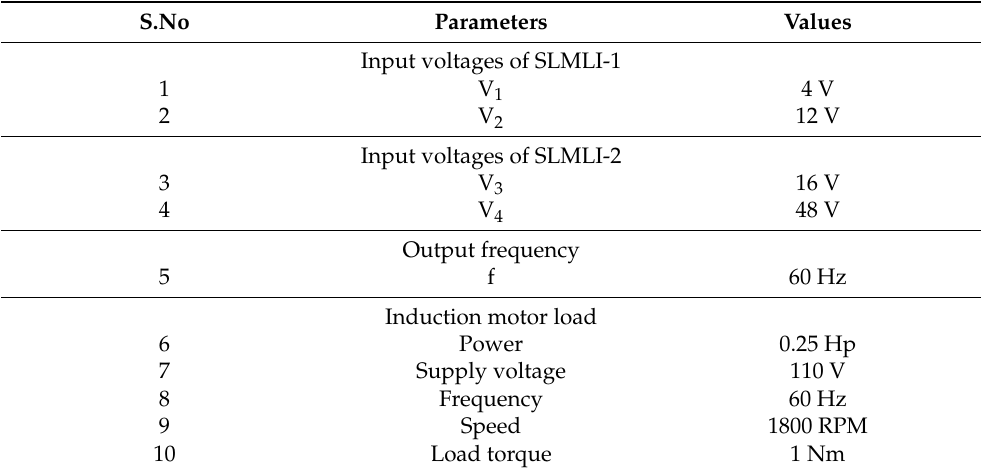
Table 6. Specification of Inverter and Induction motor.